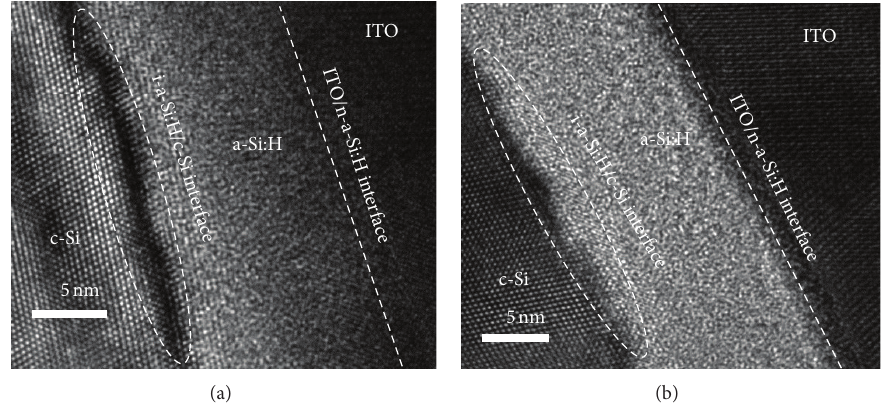
Figure 4: HRTEM images of the i-a-Si:H/p c-Si interface for (a) low-H and (b) high-H HJ solar